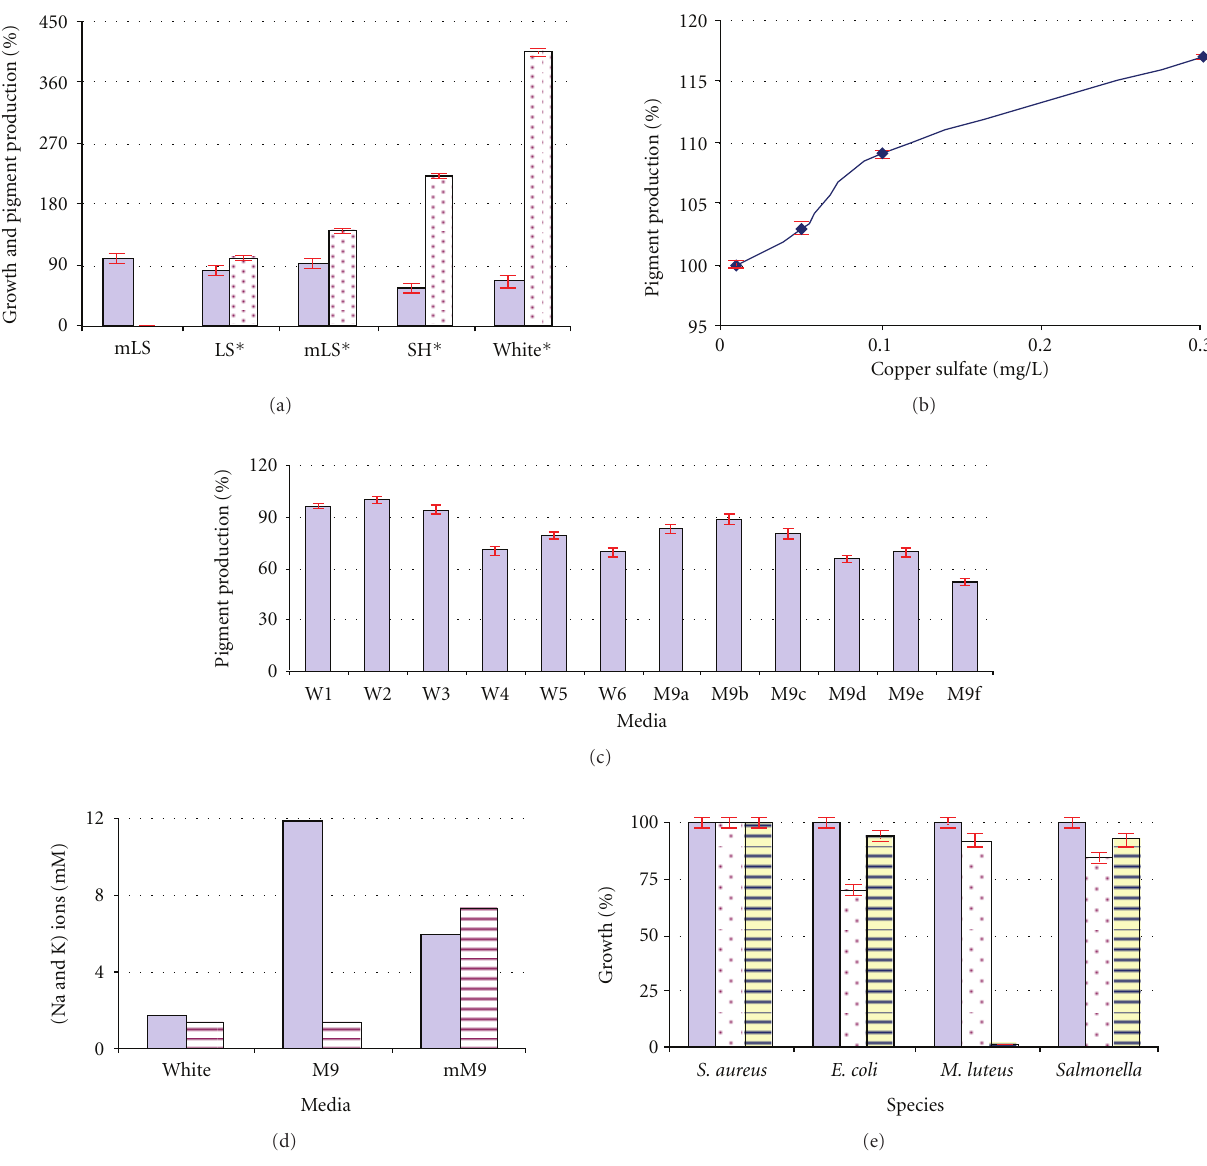
Figure 4: (a) The growth (filled bars) and the pigment production (spotted bars) of the A. euchroma callus on mLS medium containing 2,4- D (10 − 6 M), kinetin (10 − 5 M), and stared media [LS, mLS, SH and White media containing IAA (10 − 6 M), kinetin (10 − 5 M)] in the dark. The pigment production of the A. euchroma callus subcultured (b) on White medium containing IAA (10 − 6 M), kinetin (10 − 5 M), and di ff erent amounts of copper sulfate in the dark, (c) in dark on White and M9 media containing [W1&M9a (IAA 10 − 7 M, kinetin 10 − 5 M), W2&M9b (IAA 10 − 6 M, kinetin 10 − 5 M), W3&M9c (IAA 10 − 5 M, kinetin 10 − 5 M), W4&M9d (IAA 10 − 7 M, kinetin 10 − 6 M), W5&M9e (IAA 10 − 6 M, kinetin 10 − 6 M), W6&M9f (IAA 10 − 5 M, kinetin 10 − 6 M)], ( d) The amounts of the K + and Na + ions in White, M9, and mM9 media, (e) The growth of the selected bacteria in the liquid Mueller-Hinton (filled bars) containing THF (spotted bars), 200 µ g/mL THF extract (dashed bars). All the media applied in the experiments of 4a-d contained 30g/L of